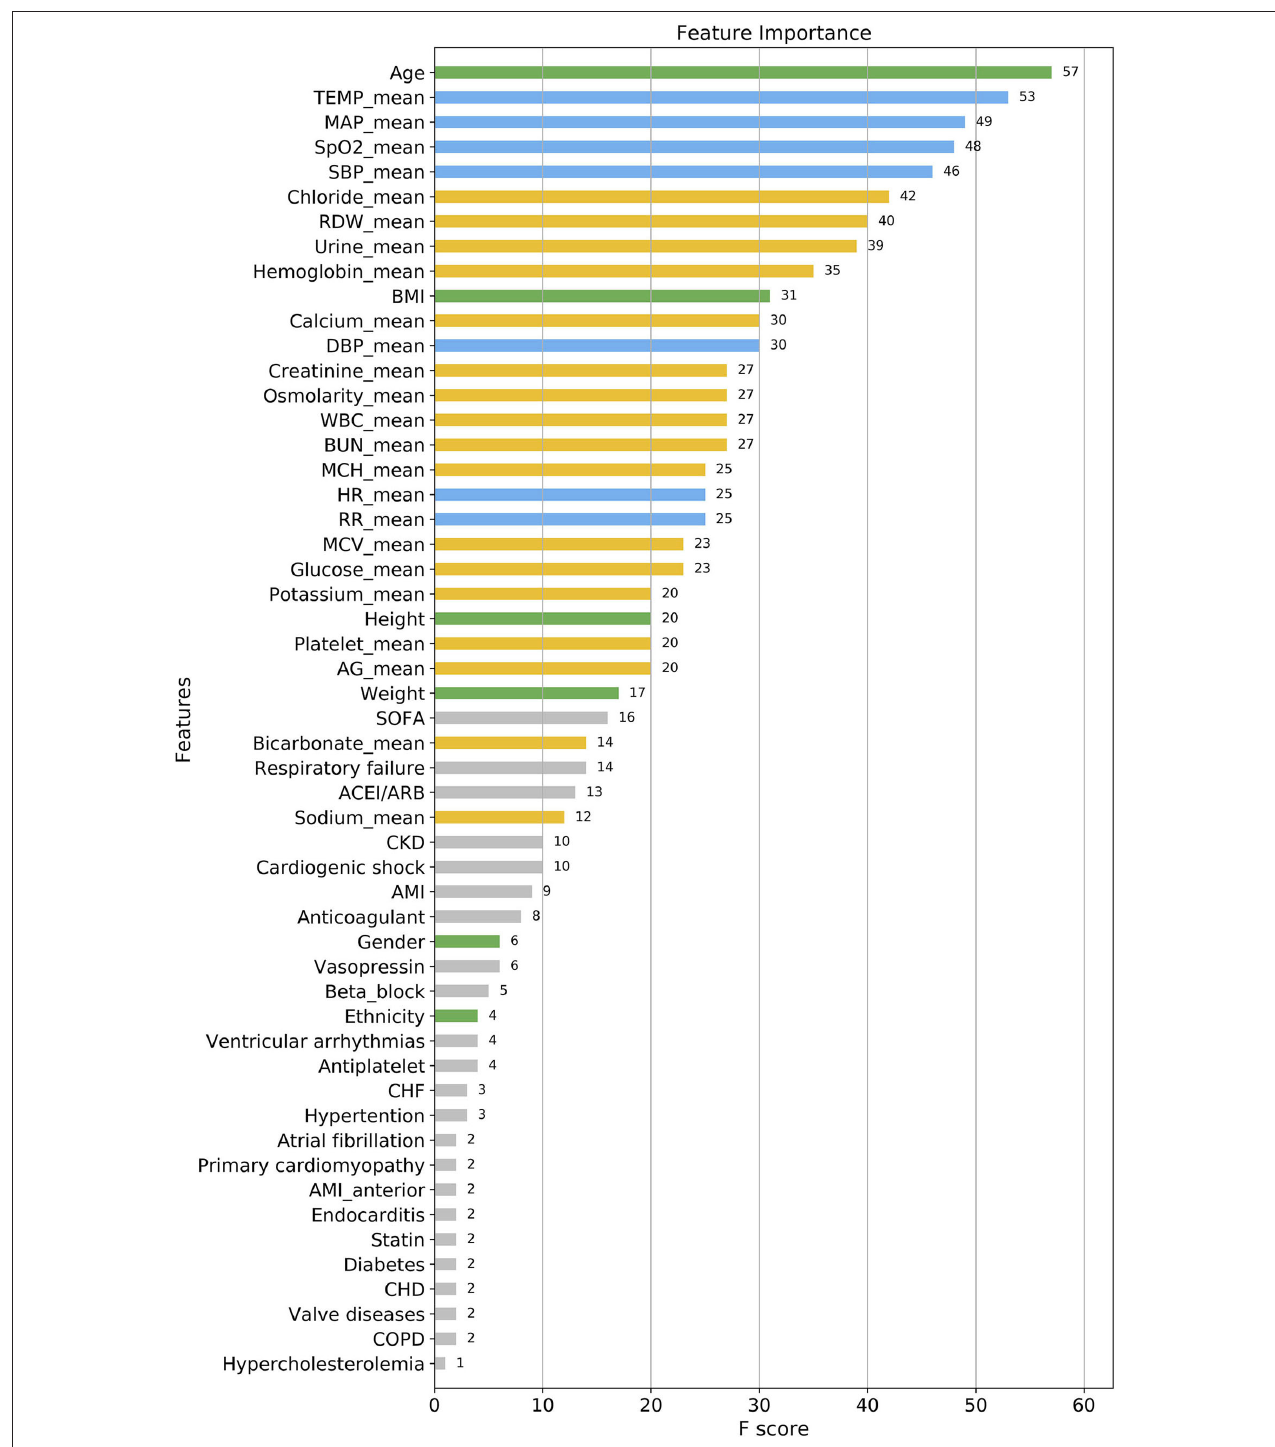
FIGURE 3 | Feature importance score ranking for 56 clinical features of the four-group XGBoost predictor. The information reflects the contribution of different features to the classification performance of XGBoost model (from top to bottom). Green , demographic data; Blue , vital signs; Yellow , laboratory parameters; Gray , others. TEMP, temperature; MAP, mean arterial pressure; SpO2, oxygen saturation; SBP, systolic blood pressure; RDW, red blood cell volume distribution width; BMI, body mass index; DBP, diastolic blood pressure; WBC, white blood cell; BUN, blood urea nitrogen; MCH, mean corpuscular hemoglobin; HR, heart rate; RR, respiratory rate; MCV, mean corpuscular volume; AG, anion gap; SOFA, sequential organ failure score; CKD, chronic kidney disease; AMI, acute myocardial infarction; CHF, congestive heart failure; CHD, coronary heart disease; COPD, chronic obstructive pulmonary diseases.